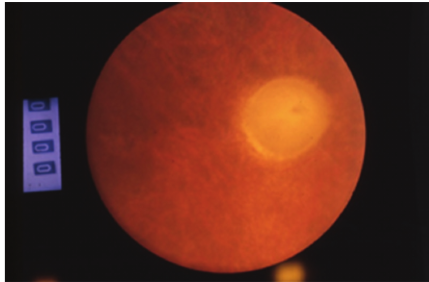
Figure 3: Behcet’s disease, disk